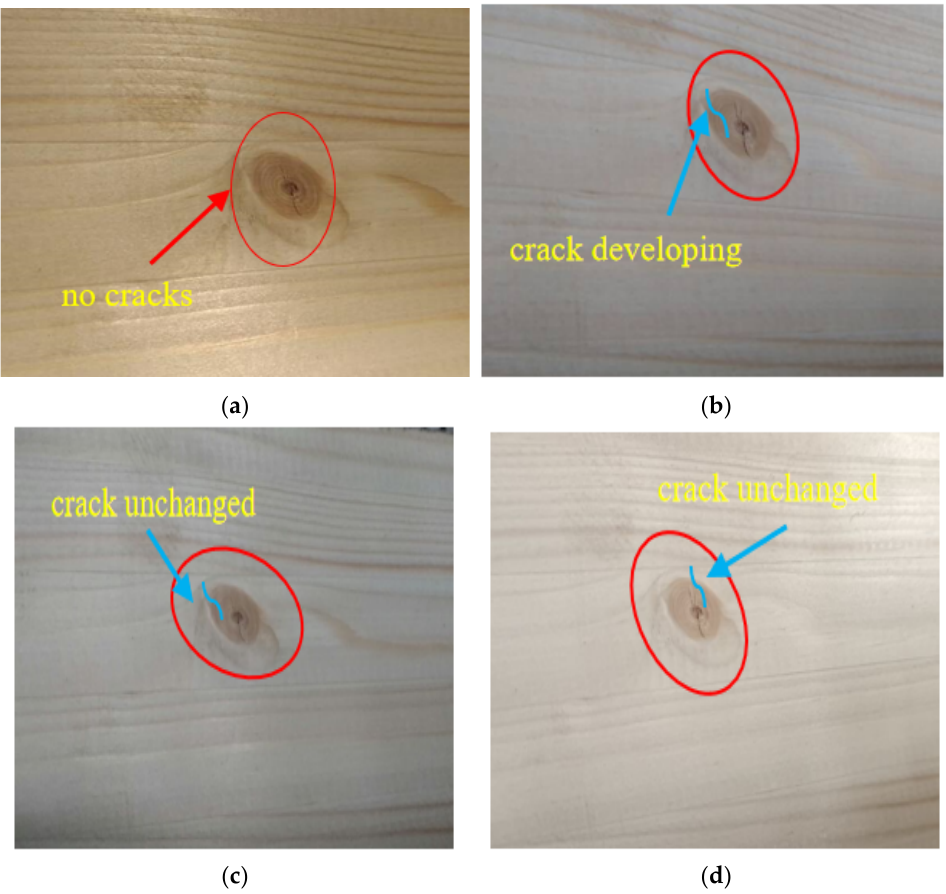
Figure 7. Long-term loading phenomenon of prestressed glulam continuous beam. ( a ) Test for 1 day; ( b ) test at 60 days; ( c ) test at 120 days; ( d ) test at 180 days.